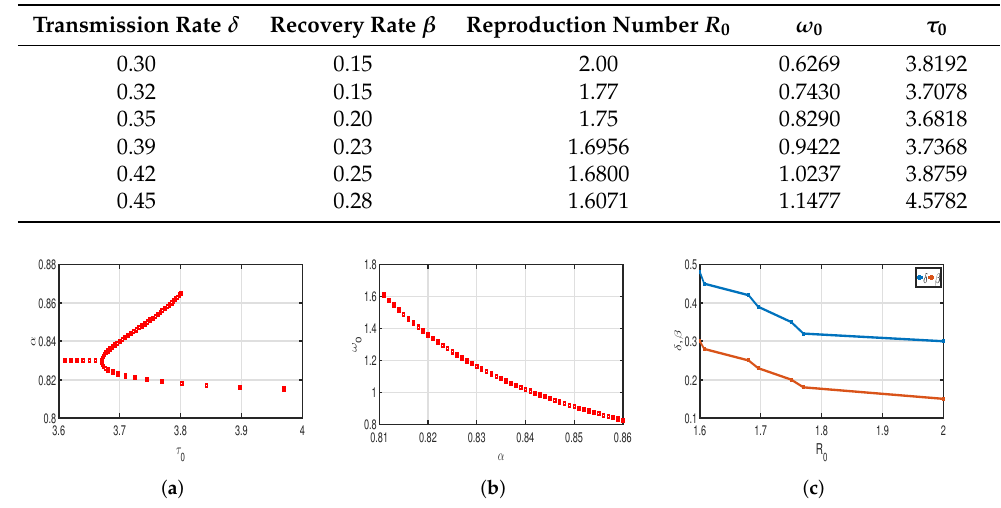
Figure 2. ( a ) Bifurcating parameter τ 0 . ( b ) Critical frequency ω 0 . ( c ) Basic reproduction number R 0